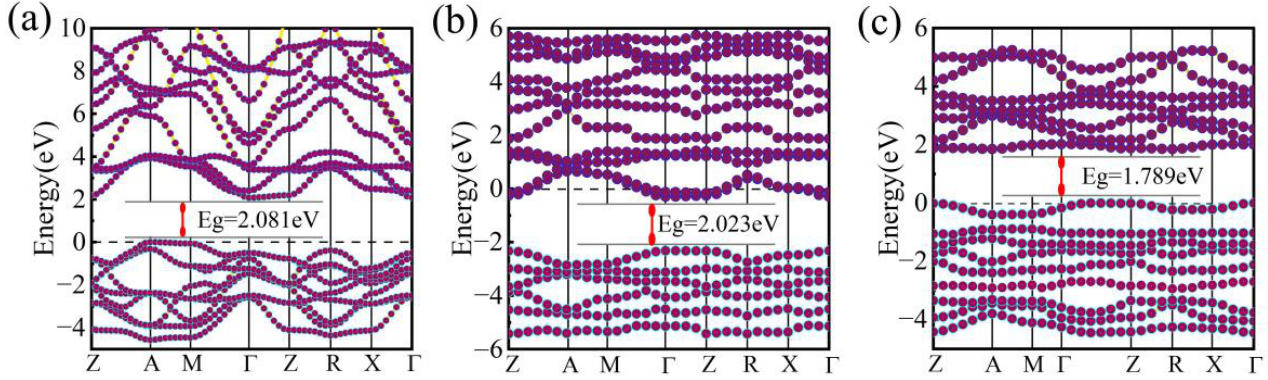
Figure 2. Electronic band structures of ( a ) pristine BaTiO 3 , ( b ) Ba site doping, and ( c ) Ti site doping.